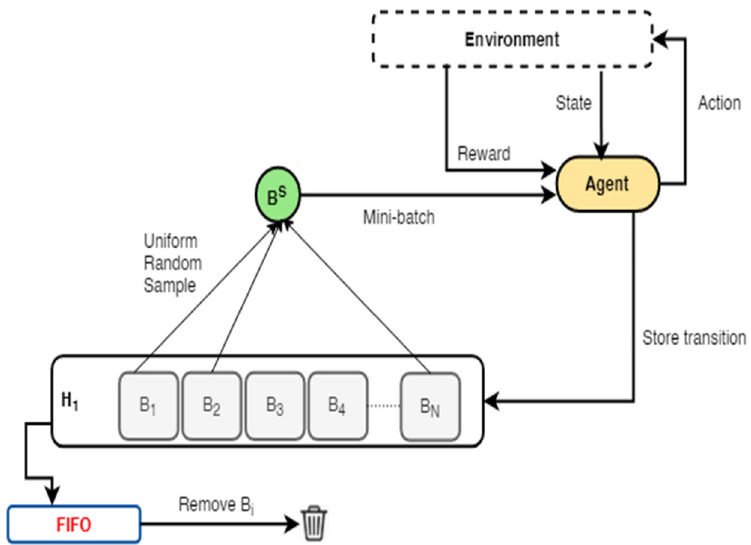
Figure 1. An illustration of the standard experience replay (ER) framework. A specified batch size of transitions is uniformly sampled at random from the replay buffer to train the agent. When the buffer is full, the First-In-First-Out (FIFO) retention strategy is applied to ensure that older transitions are replaced with newer ones.